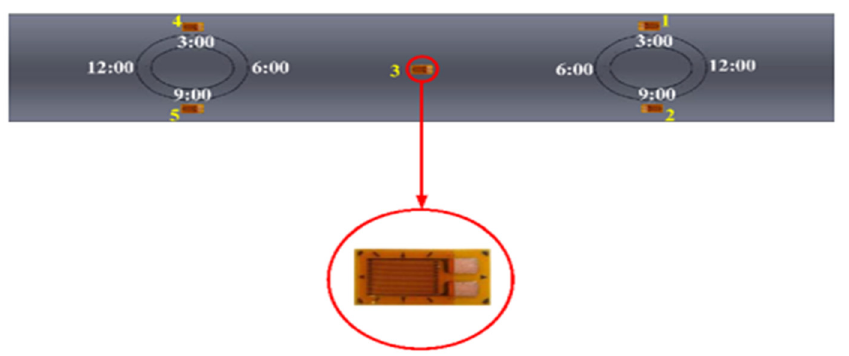
Figure 4. Typical strain gage location and position around the hand-holes.